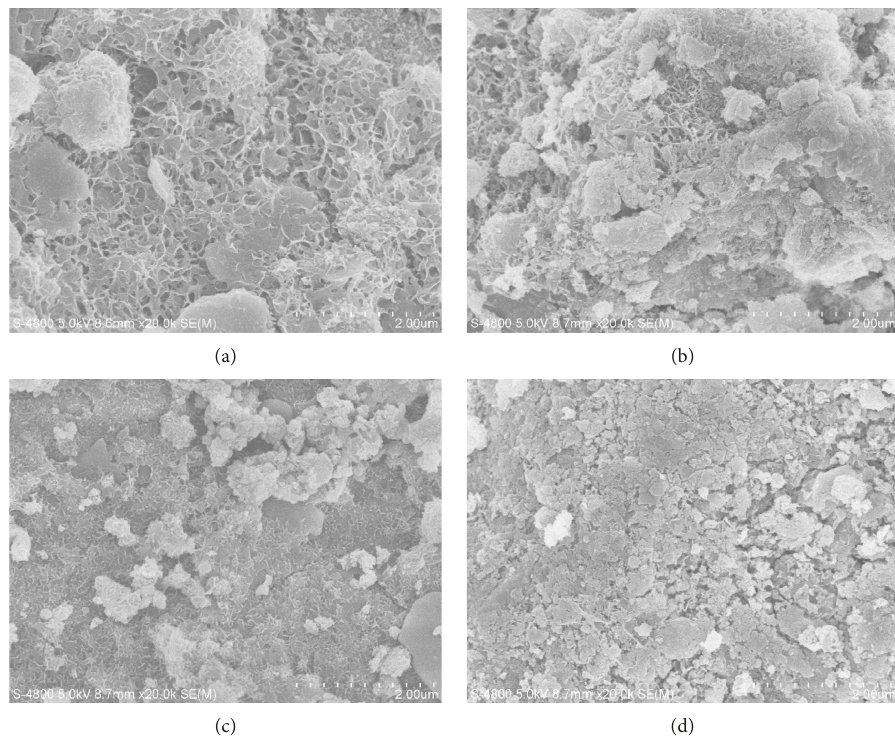
Figure 9: SEM images of slag particles with w/s � 0.4 in the solution pH 13.58. (a) 5 ° C, 1day; (b) 35 ° C, 1 day; (c) 5 ° C, 14days; (d) 35 ° C,